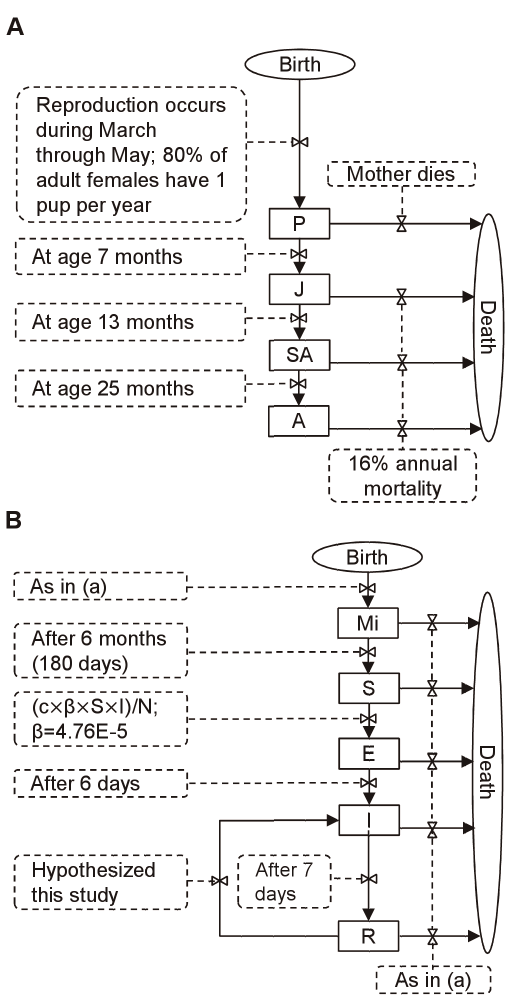
Figure 1. Conceptual model of the possible role of recrudes- cence in the persistence of Hendra virus in isolated flying-fox populations representing the daily dynamics of a colony consisting of (A) the various life history stages (pups, P; juveniles, J; pre-reproductive sub-adults, SA; reproductively mature adults, A), and (B) the various disease stages (mater- nally immune young-of-the-year, Mi; susceptible, S; exposed and latently infected, E; infectious, I; and recovered, R) individuals.